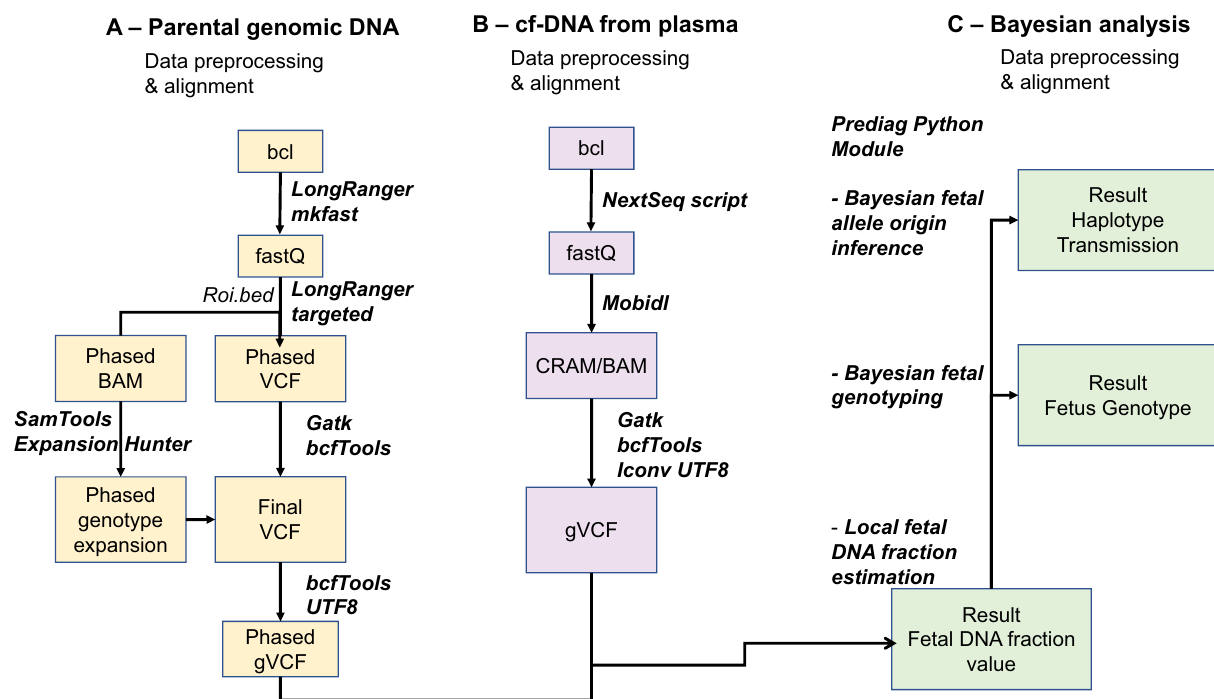
Figure 2. Different steps of the bioinformatic pipelines used in our study. The third stepis a modified Hoobari pipeline for noninvasive prenatal